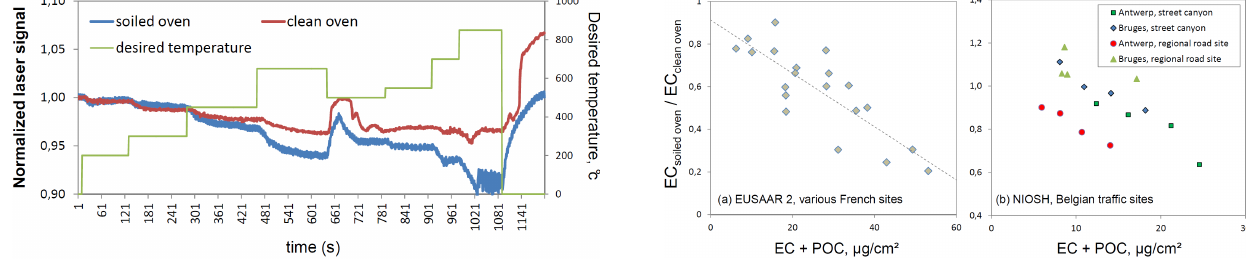
Figure 7. Ratios of EC concentrations obtained when using clean Fig. 7. Ratios of EC concentrations obtained when using clean and soiled (extreme case) ovens as a function of 3 the EC + POC filter loading. using the EUSAAR 2 (left panel, Fig. 7a) and NIOSH (right panel, Fig. 7b) thermal 4 and soiled (extreme case) ovens as a function of the EC+POC filter protocols. 5 loading using the EUSAAR 2 (a) and NIOSH (b) thermal